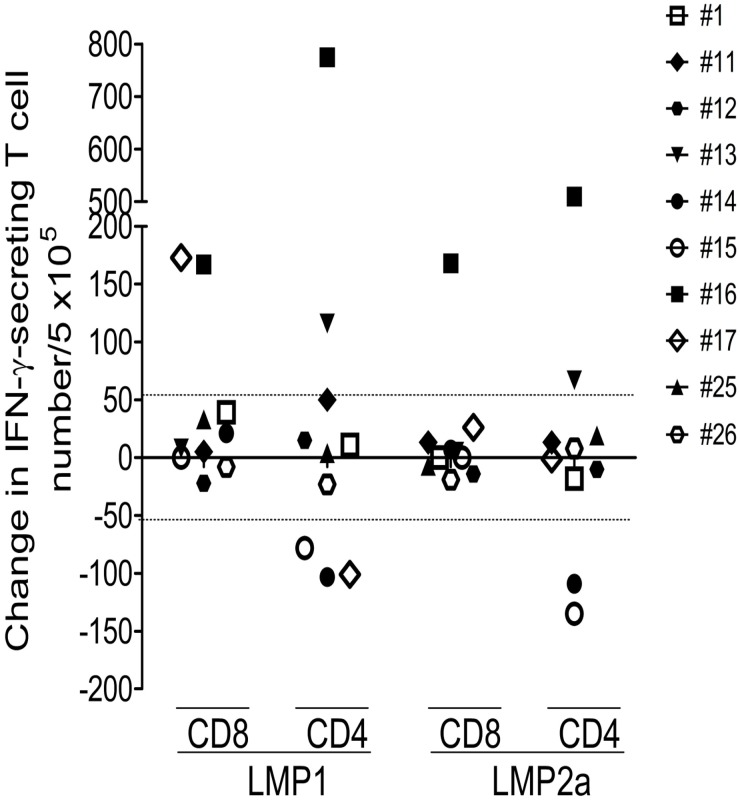
Analysis of LMP1- or LMP2a-specific immune responses by IFN-γ ELISPOT assays in a subsequent T cells (3–15 months apart).LMP1 or LMP2a proteins were obtained from ten EBV-seropositive healthy donors. Result is shown as variation in IFN-γ-secreting T cell number per 5 × 105 cells.